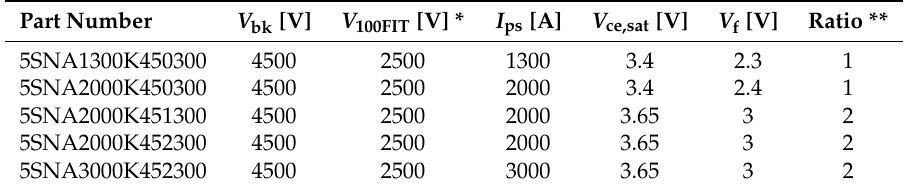
Table 3. Press-pack semiconductor device data